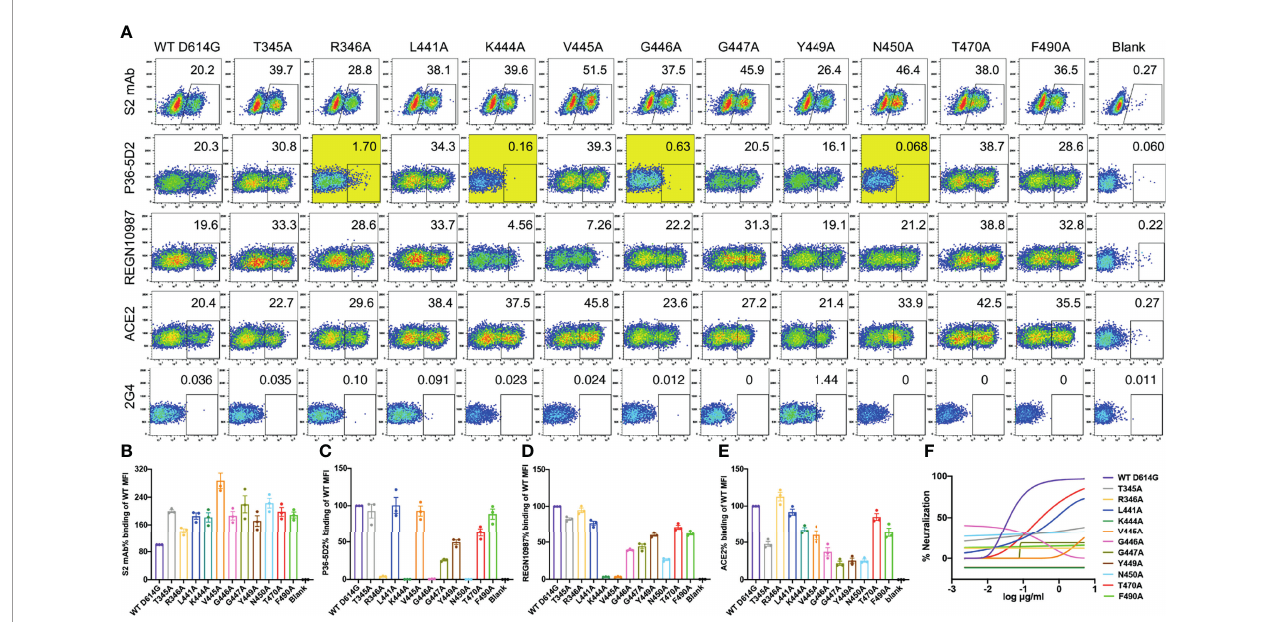
FIGURE 3 | Impact of single alanine mutated residues on P36-5D2 binding and neutralization. (A) Wild-type and single alanine mutated spike were expressed on the surface of HEK 293T cells, incubated with P36-5D2, REGN10987, or ACE2, followed by staining with anti-human IgG Fc phycoerythrin (PE) or anti-His PE, and analyzed by FACS. For each panel, the X -axis means tested antibody or ACE2 binding PE/FITC and the Y -axis means side-scattered light (SSC). The gated cell percentages are shown. (B) The S2 monoclonal antibody (mAb) is a positive control antibody used for spike expression normalization. (C – E) The relative mean fl uorescence intensity (MFI) of mAbs or ACE2 binding was determined by comparing the total MFI in the selected gate between the spike variants and WT D614G. 2G4 targeting Ebola virus glycoprotein (EBOV GP) is a negative control mAb. NC denotes HEK 293T cells with mock transfection. Alanine mutated residues completely destroying P36-5D2 binding are highlighted in yellow . Data are presented as the mean ± SEM from three independent experiments. (F) Impact of single alanine mutated residues on pseudovirus neutralization sensitivity to P36-5D2. Results are presented as the mean value from three independent